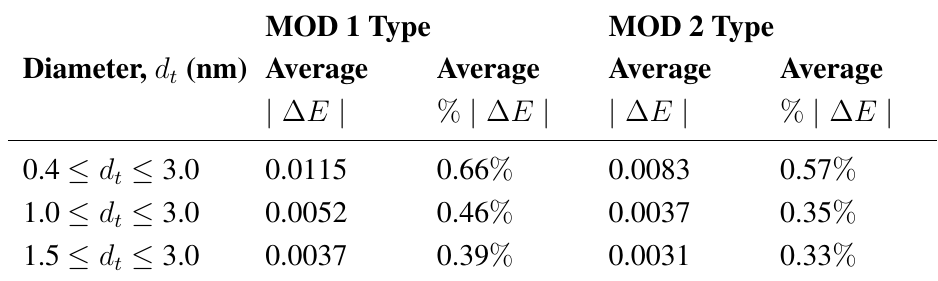
and corresponding average 22